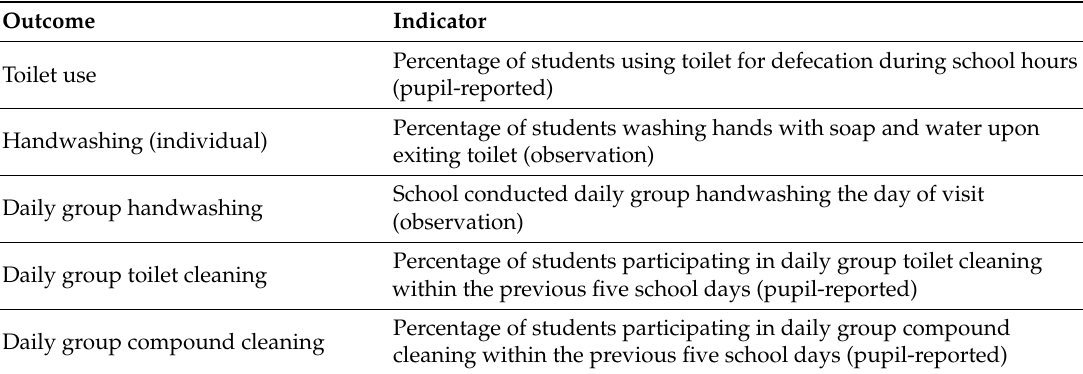
Table 2. WinS behavioral outcomes and